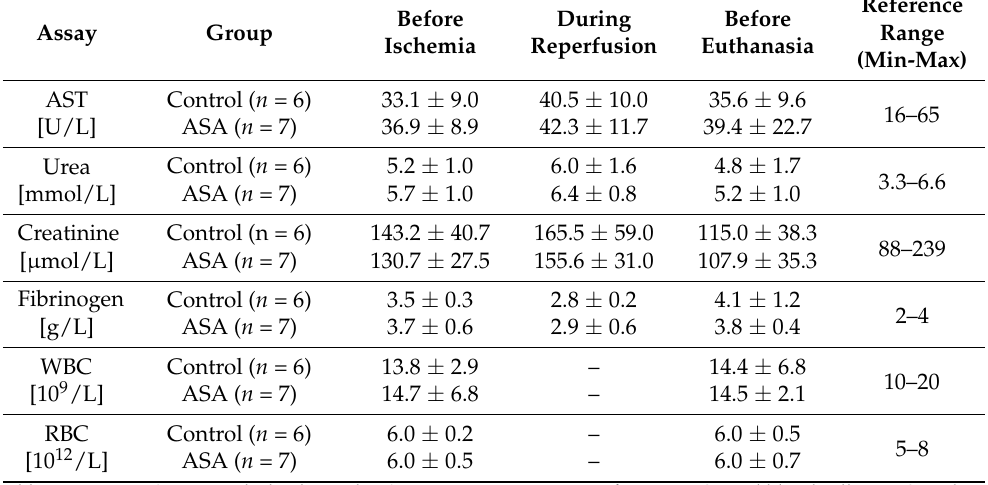
Table 1. Levels of biochemical and morphological blood tests used to assess the health status of pigs ( n = 13) subjected to a myocardial ischemia-reperfusion protocol assessing the effectiveness of intracoronary administered acetylsalicylic acid (ASA). The results are presented as mean ± standard deviation and were analyzed using two-way ANOVA. Assay Group